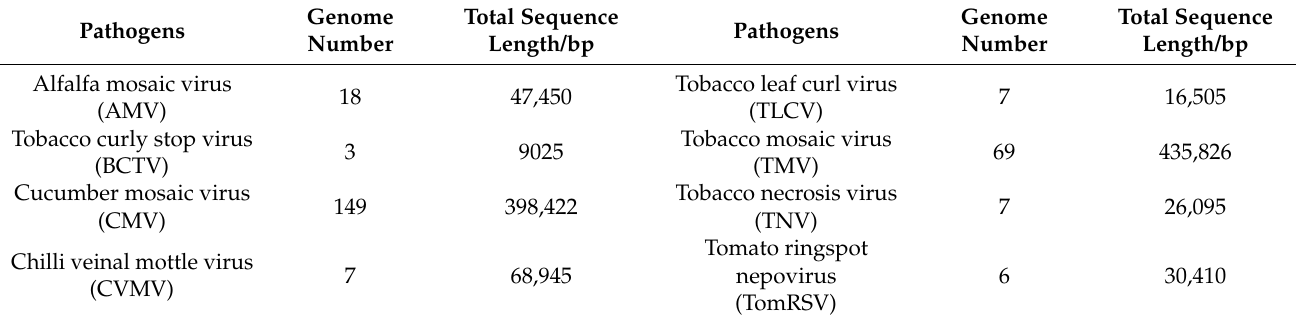
Table 2. Information of 19 Nicotiana